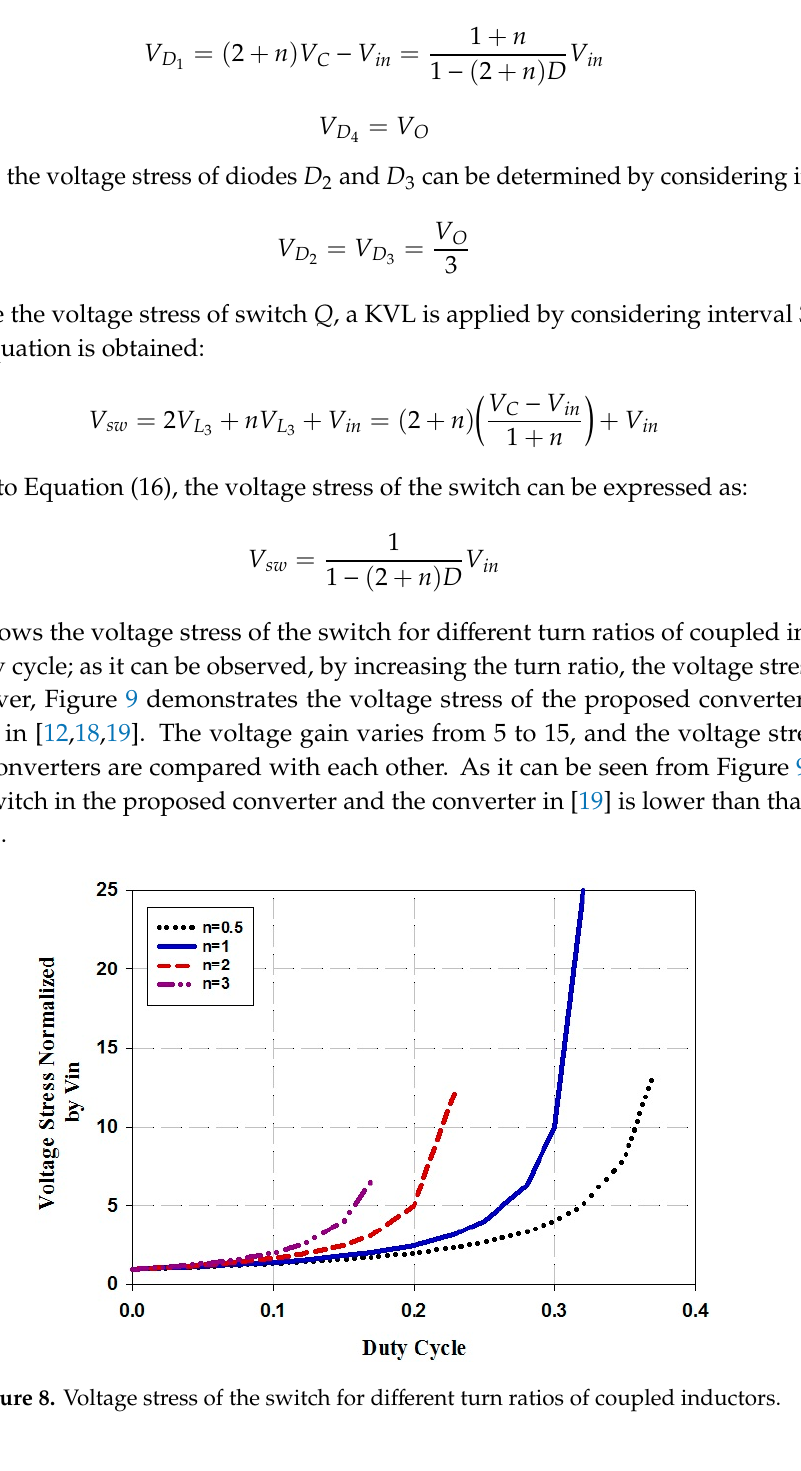
Figure 9. Voltage stress of the switch in the proposed converter and the converters in [12,18,19]. 3.3. Converter Analysis and Design Guideline The ZCS occurs for the diodes D 2 , D 3 and D 4 for the sake of resonance between leakage inductances of L 5 (or L 6 ) and C 5 (or C 6 ). The full-resonance can be done if the following equation is satisfied: